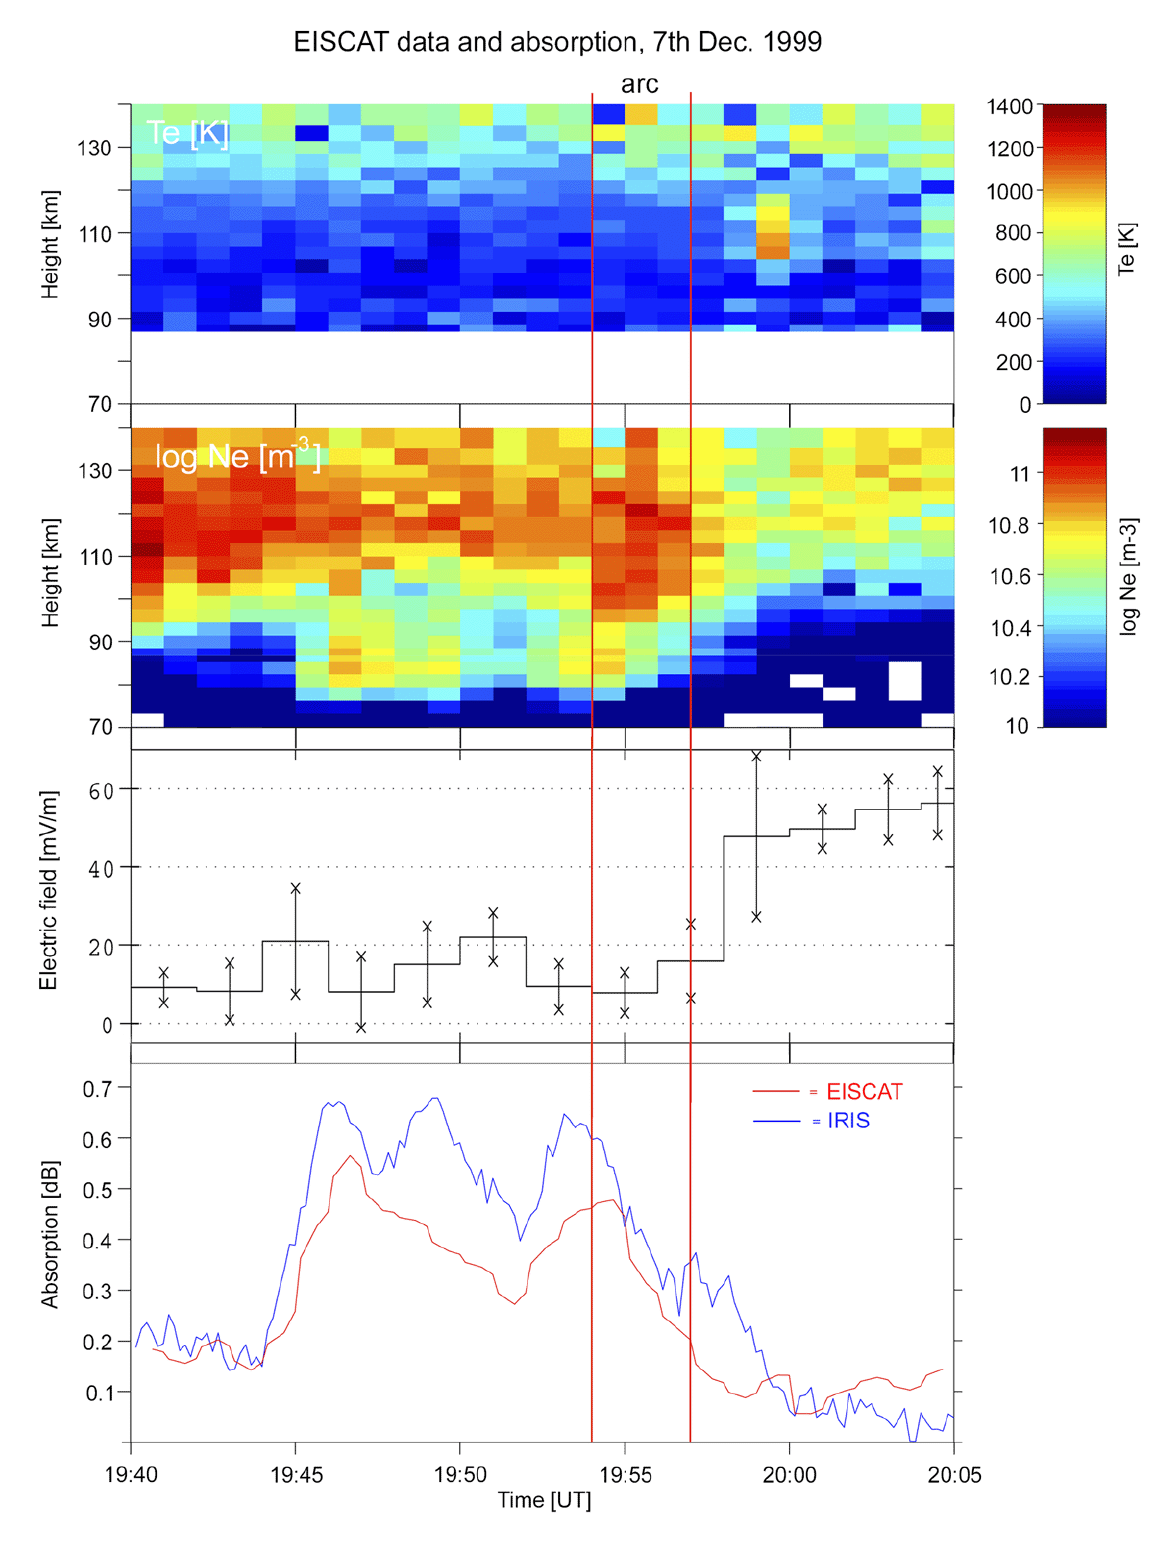
Fig. 3. The EISCAT data for Event 1 on 7 December 1999. The top panel shows the electron temperature T e from EISCAT for the height range 100–140km with a 60s integration time. The T e was obtained from the MSIS model for the height range of 70–100km (not shown). The second panel shows the electron density N e from a power profile for 70–86km and from analyzed N e from 86 to 140km with a 60s integration time. The third panel shows the total intensity of the horizontal electric field. The integration time of 120s was used for calculating the electric field. The bottom panel shows the total absorption measured with IRIS (blue line) and calculated from EISCAT measurements (red